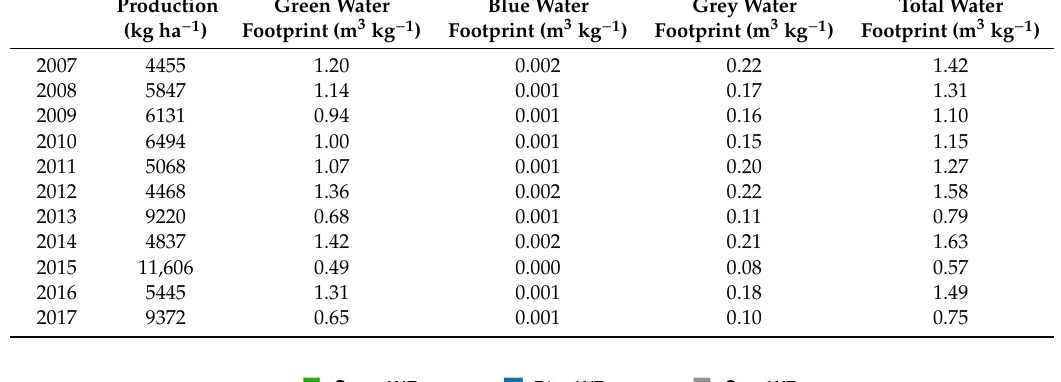
Table 2. Olive production, green, blue and grey WF 2007–2017 as m 3 of water per kg of olives − 1 .